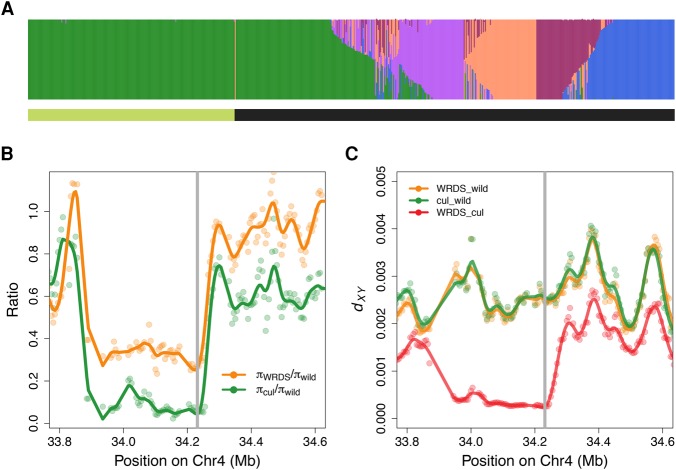
sh4 haplotypes in wild and domesticated rice populations. (A) Local ancestry inference at sh4 locus for K = 5. The bar at the bottom denotes O. sativa (green) and O. rufipogon (black) accessions, respectively. (B) Diversity reduction at the selective sweep region of sh4. The y-axis shows the ratio of pairwise differences estimator (π) of nucleotide diversity among populations. (C) dXY values between populations at the selective sweep region of sh4. The gray line indicates the sh4 gene region in B and C.